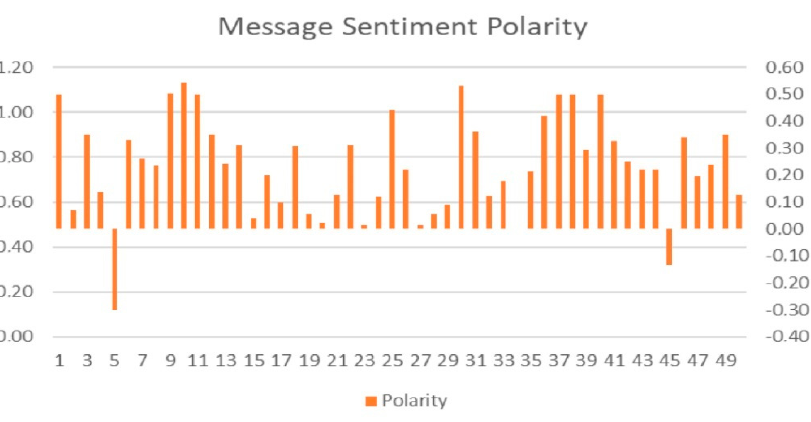
Figure 10. Message sentiment polarity. Visualization of sentiment polarity of messages.